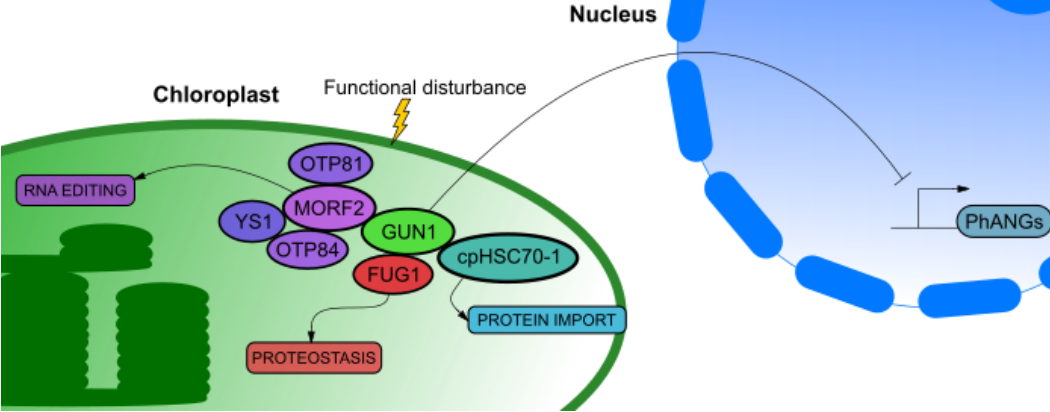
Figure 3. Retrograde signals mediated by GENOMES UNCOUPLED 1 (GUN1). In response to functional disturbance of chloroplast GUN1 inhibits expression of photosynthesis-associated nuclear genes (PhANGs), regulates protein import through interaction with cpHSC70-1, maintains proteostasis through interaction with FUG1 and modulates RNA editing through interaction with MULTIPLE ORGANELLAR RNA EDITING FACTOR 2 (MORF2).